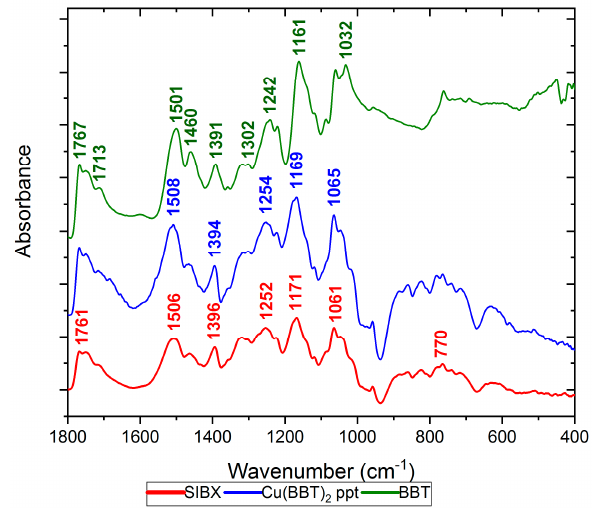
Figure 11. DRIFT spectra of xanthate, thionocarbamate and copper thionocarbamate precipitates.